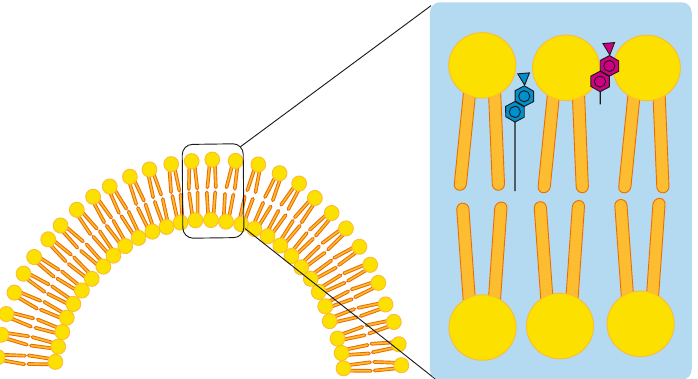
Figure 5. The location of laurdan (blue) and prodan (purple) compounds in the phospholipid bilayer of liposome. Laurdan molecules locate closer to the phospholipid glycerol groups than prodan, whose fluorophore is positioned closer to the hydrophilic surface of a bilayer [25]. It was determined that the tested compounds were located in the bilayer where prodan (purple) was located.